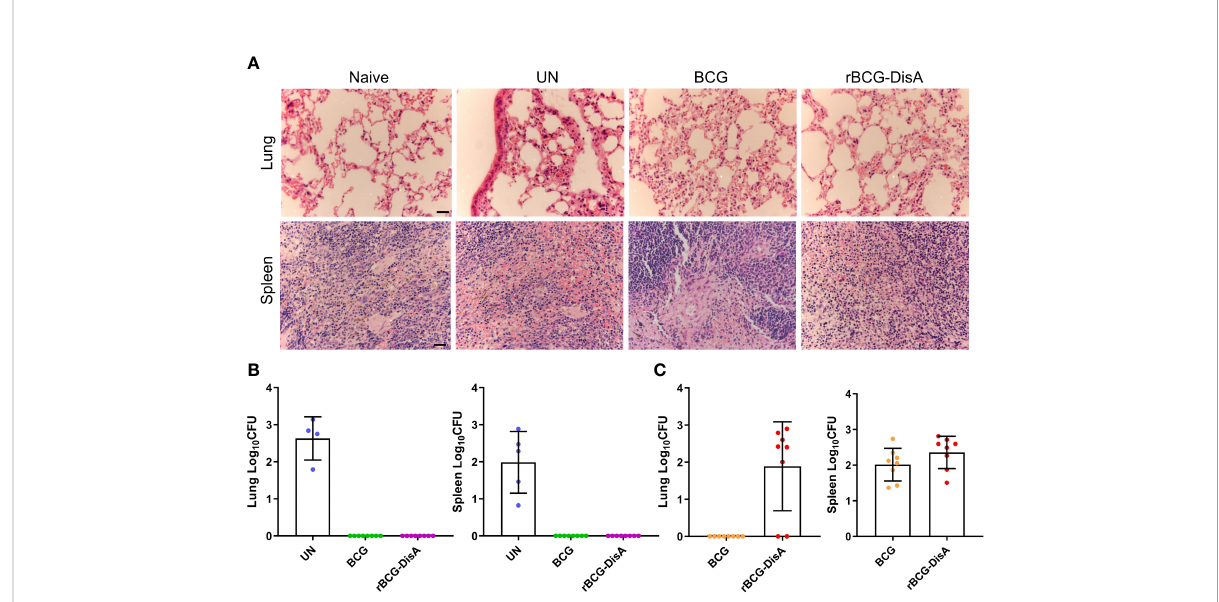
FIGURE 7 Histopathological changes and bacilli number of mice after M. tuberculosis infection. Mice were vaccinated by i.v BCG and rBCG-DisA for 12 weeks. Then, mice were infected with M. tuberculosis by i.n route, normal mice (Naïve) and M. tuberculosis infected mice without immunization (UN) were used as control. (A) At 6 weeks post infection, representative images of H&E-stained lung tissue sections at ×40 magni fi cation (scale bar=100 m m). (B, C) At 6 weeks post infection, bacilli burdens in the lung and spleen were incubated at 37°C for 3-4 weeks ( n =4~8). The colonies on the plates were determined according to the time of colony formation, morphology and genotype veri fi cation to determine whether the clone was M. tuberculosis [ ag85B (+), cfp10-esat-6 (+)] (B) or BCG/rBCG-DisA [ ag85B (+), cfp10-esat-6 (-)] (C)